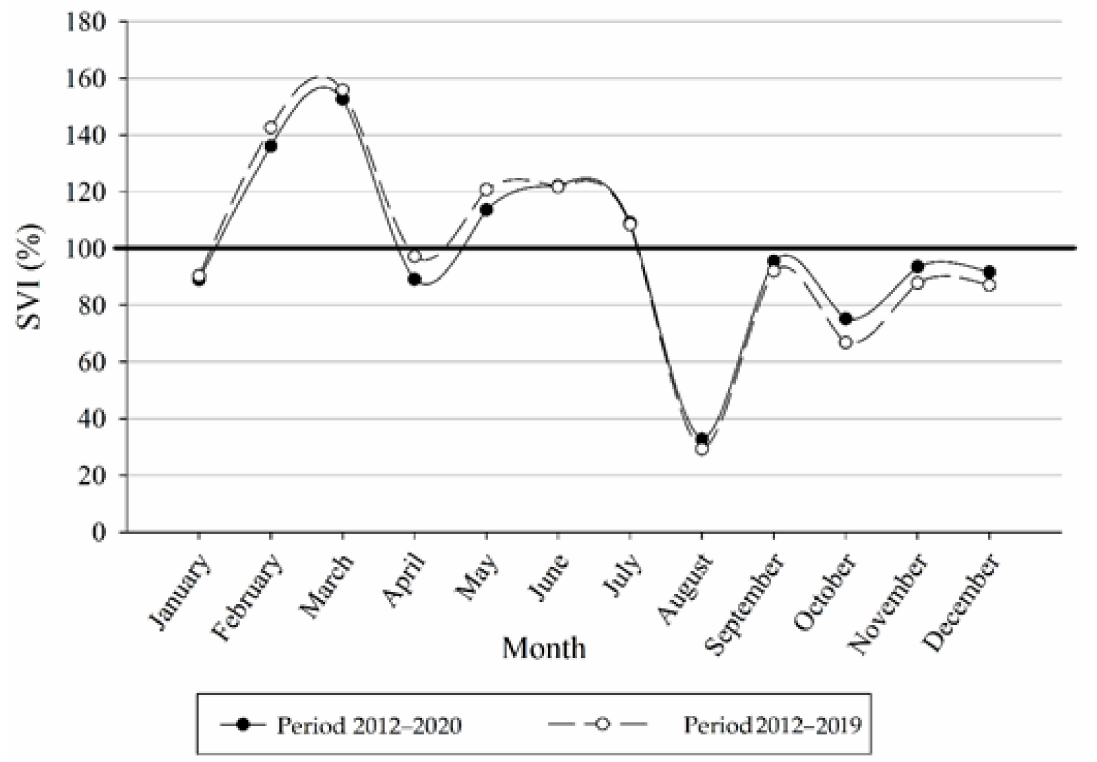
Figure 14. Seasonality pattern of vehicle embarking traffic of the port of Santander during the periods 2012–2019 and 2012–2020.